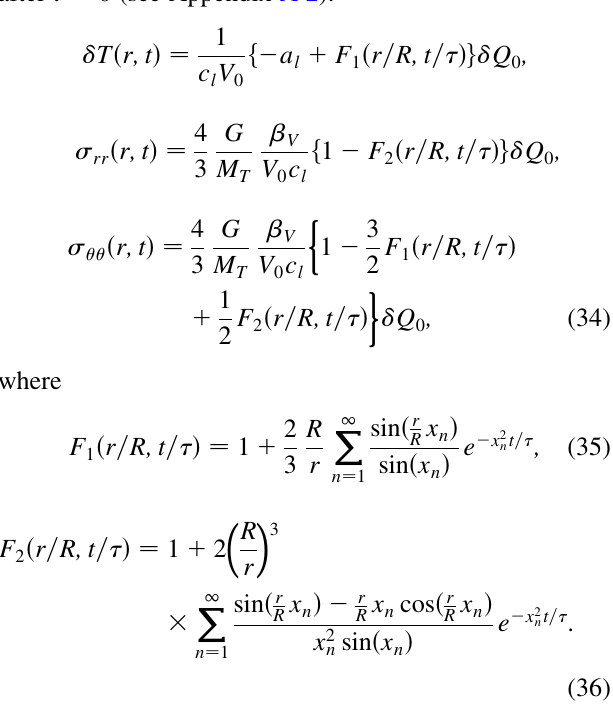
rr (cid:7) V G ¼ 4 (cid:5)Q . First, we 0 0 M T V 0 c l 3